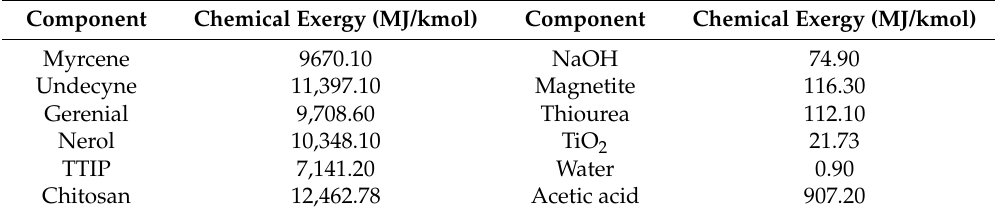
Table 5. Chemical exergy of main components for bio-adsorbent production processes.